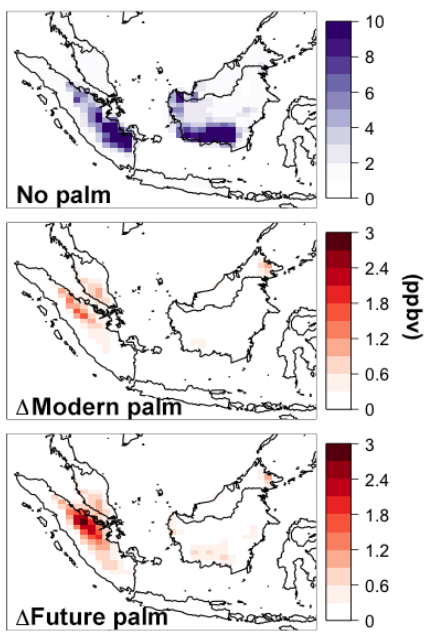
Figure 6. Annual average ozone dry deposition velocity over SEA (top) and the change due to Modern (middle) and Future (bot- tom) Palm expansion.